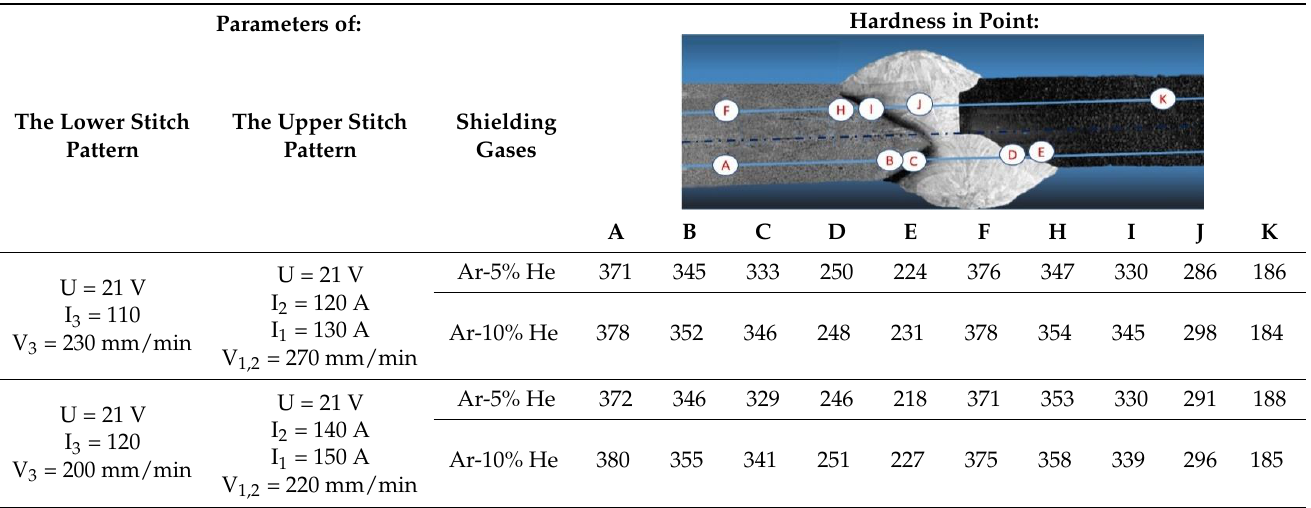
Table 3. Hardness test results on Vickers method, HAZ—heat-affected zone.